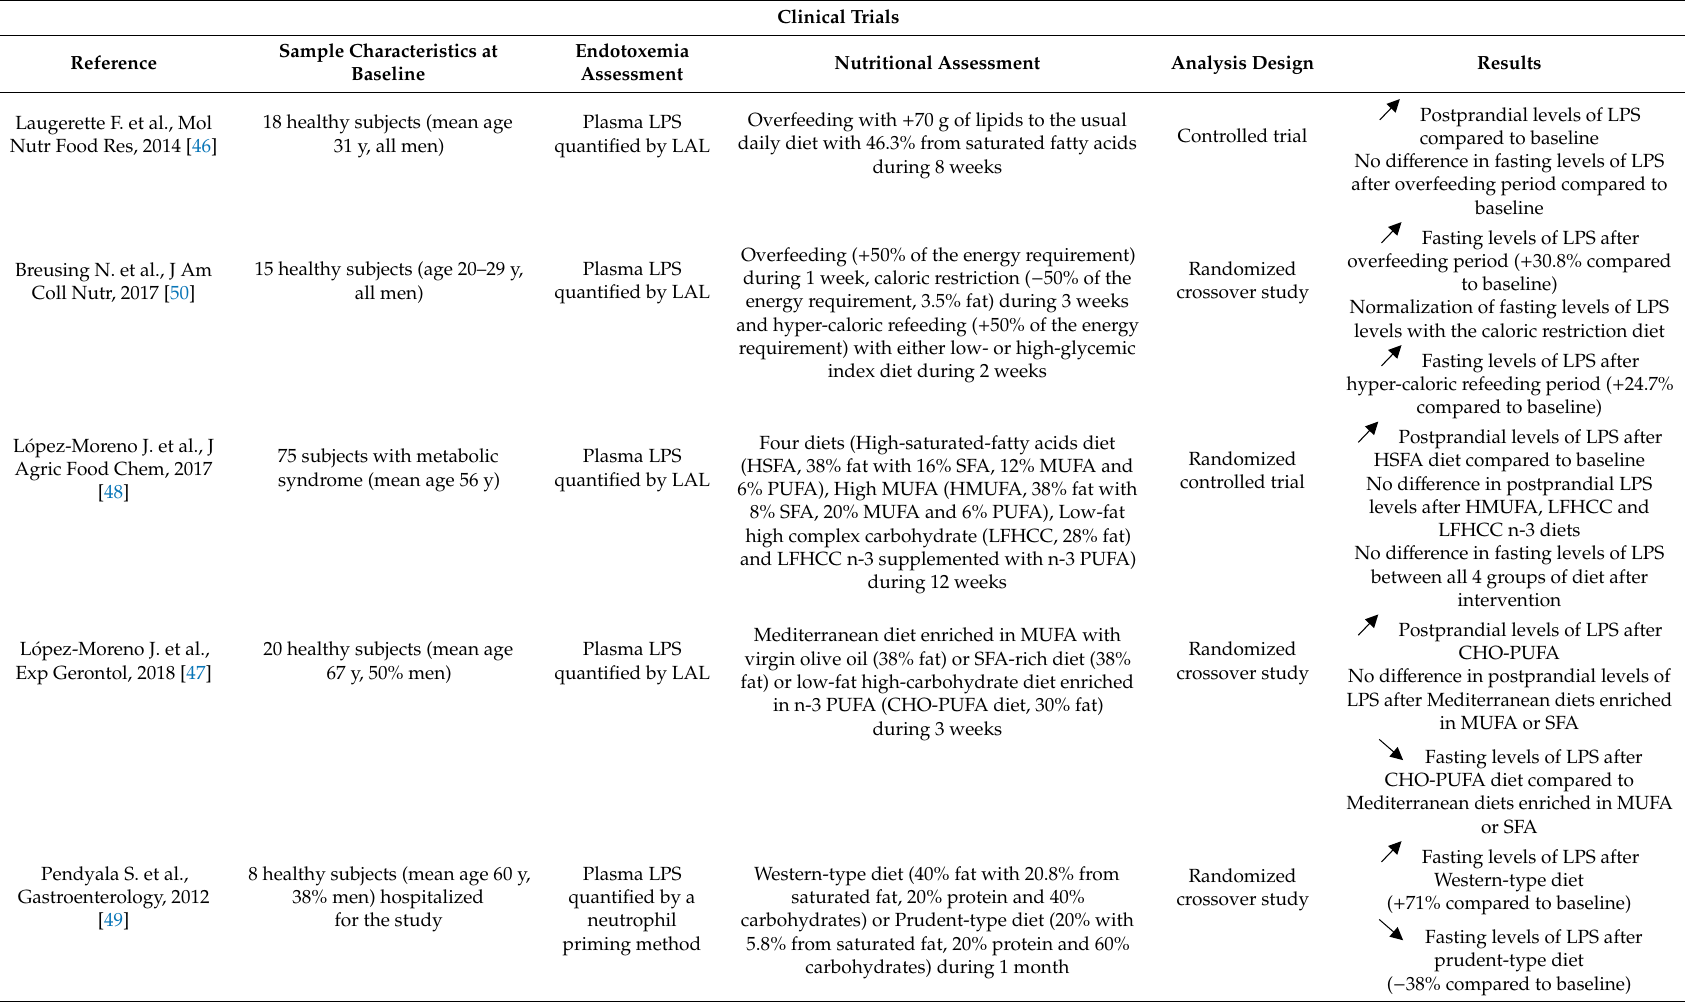
Table 1. Selective evidence on the association between a single high-fat meal and metabolic endotoxemia. Table 2. Selective evidence on the association between long-term diet and endotoxemia.